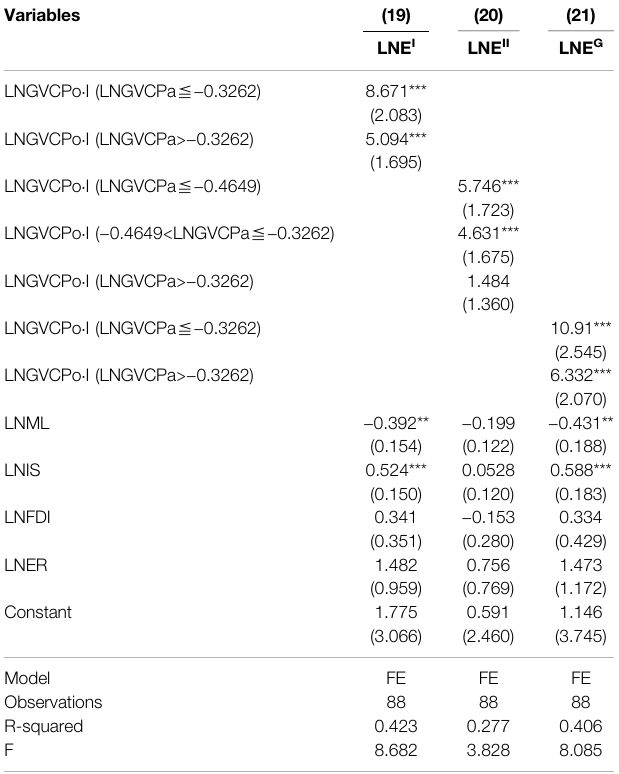
TABLE 6 | Threshold effect results of the impact of the GVC position on